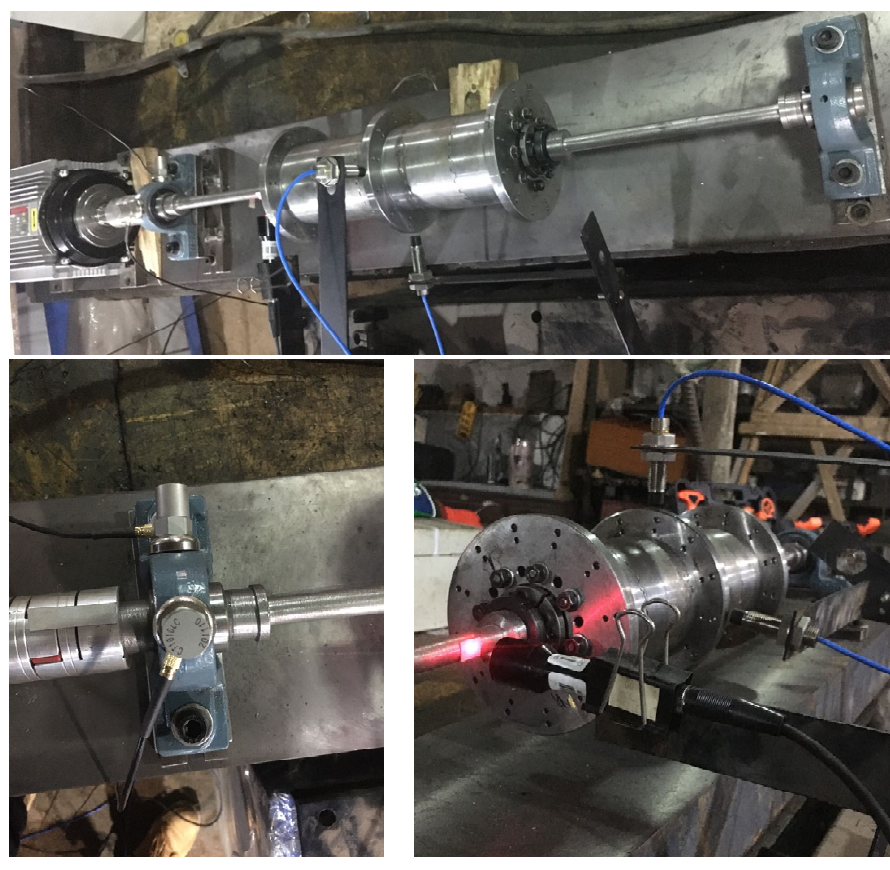
Figure 6. The test rig for response.